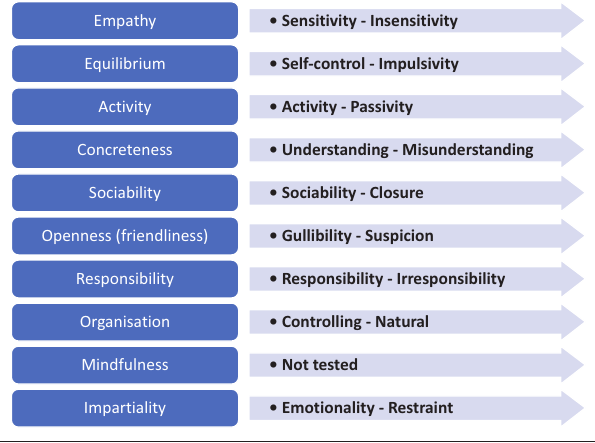
FIGURE 2: The ratio of mediators’ important professional qualities and the Five- Factor Personality questionnaire scales.